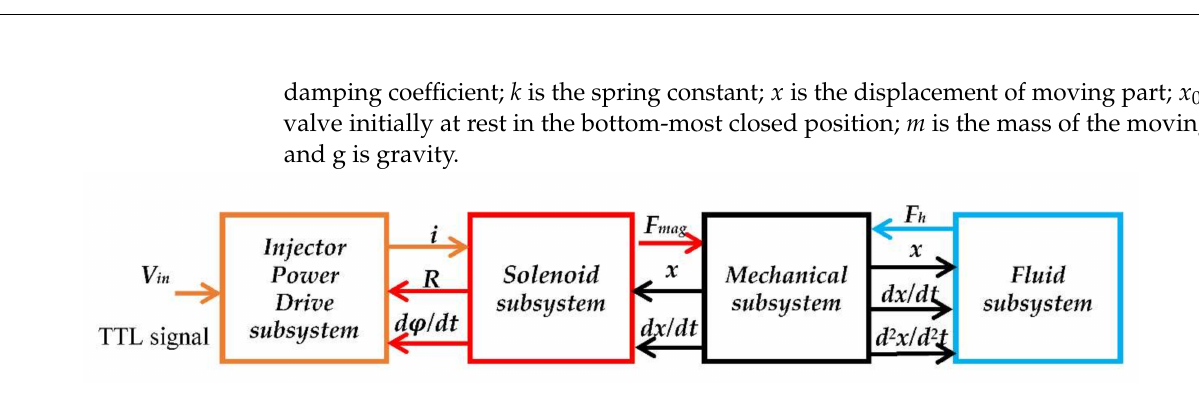
Figure 2. Block diagram of high-pressure solenoid fuel injection